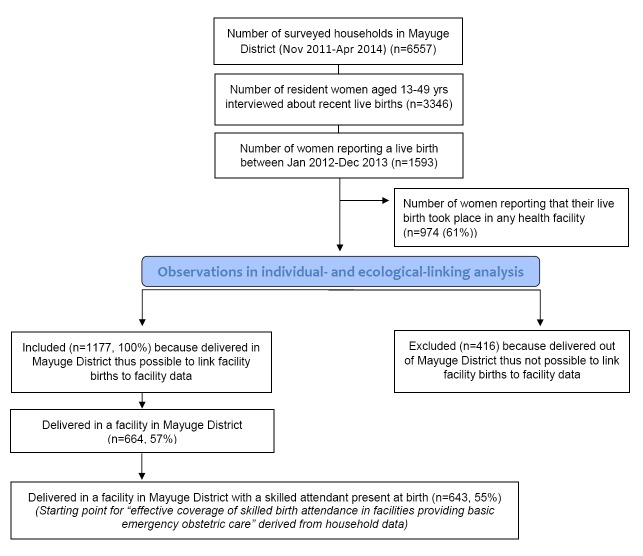
Sample selection.